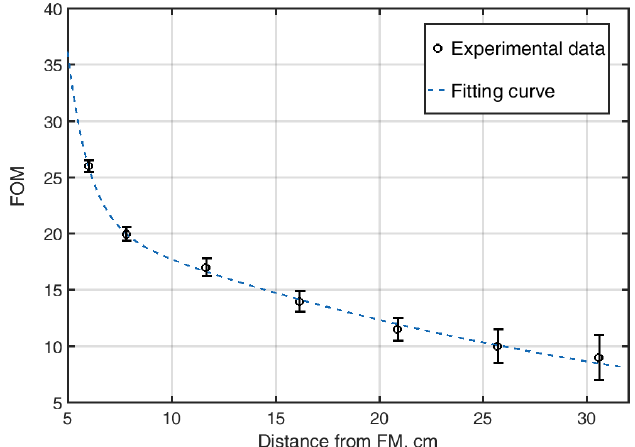
Fig. 4 Flux density of epithermal neutrons on surface of concrete structure per one source neutron. The value of FOM corresponds to the position of FM